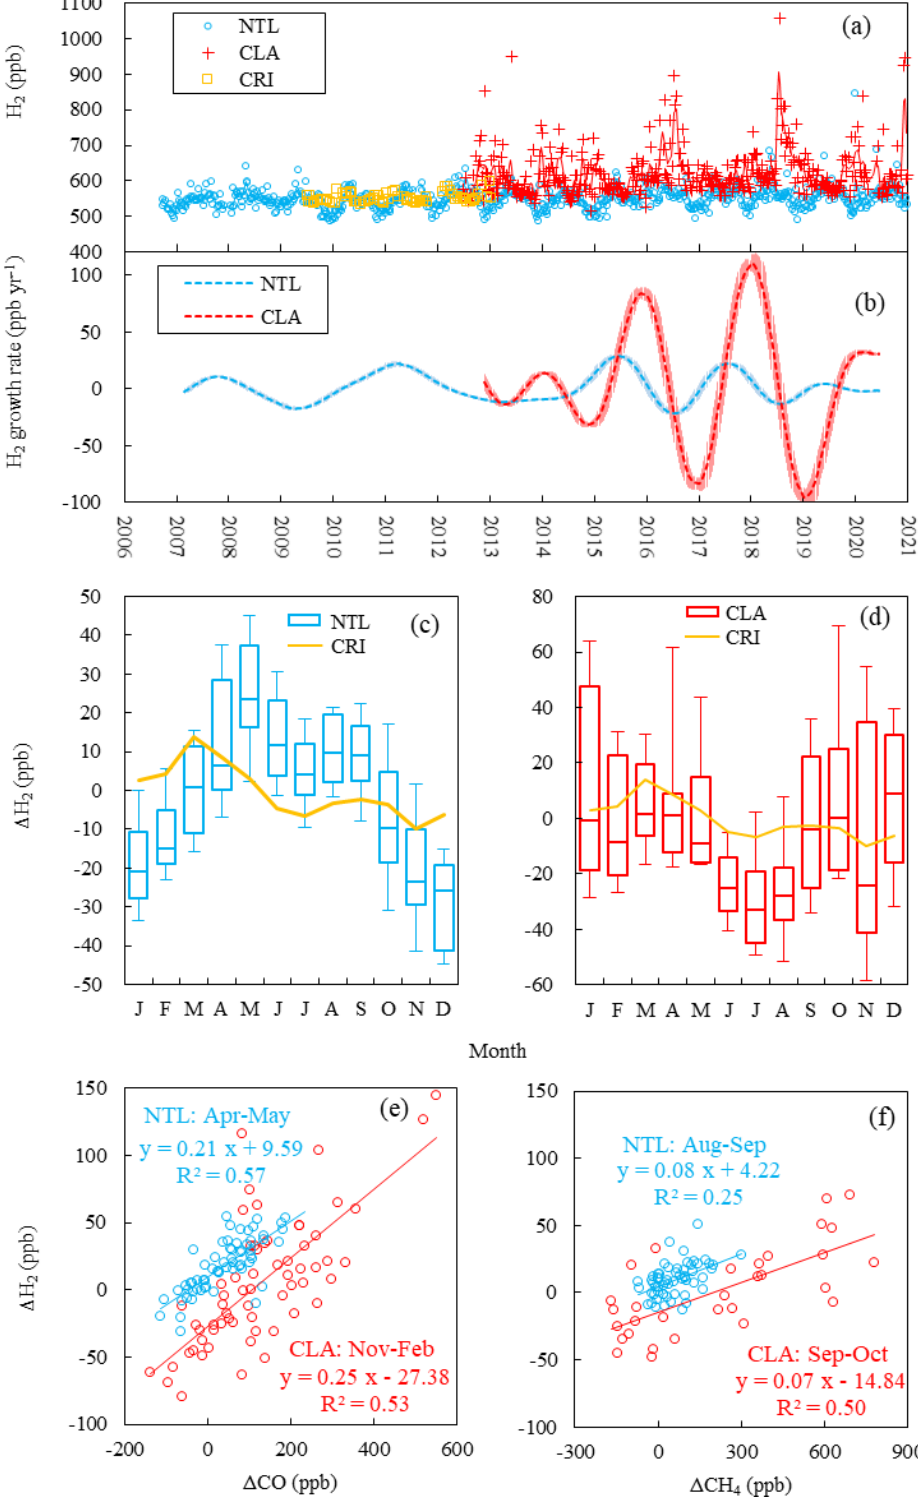
Figure 11. Time series of (a) measured values and (b) growth rate of the atmospheric H 2 mole fraction at NTL, CLA, and CRI in 2006–2020 and seasonal variation in the H 2 mole fraction at (c) NTL and (d) CLA and scatter plots for the relationship of (e) (cid:49) H 2 and (cid:49) CO at NTL during April–May and at CLA during November–February when biomass burning occurred frequently, and (f) (cid:49) H 2 and (cid:49) CH 4 at NTL during August–September and at CLA during September–October when the maximum CH 4 mole fraction was